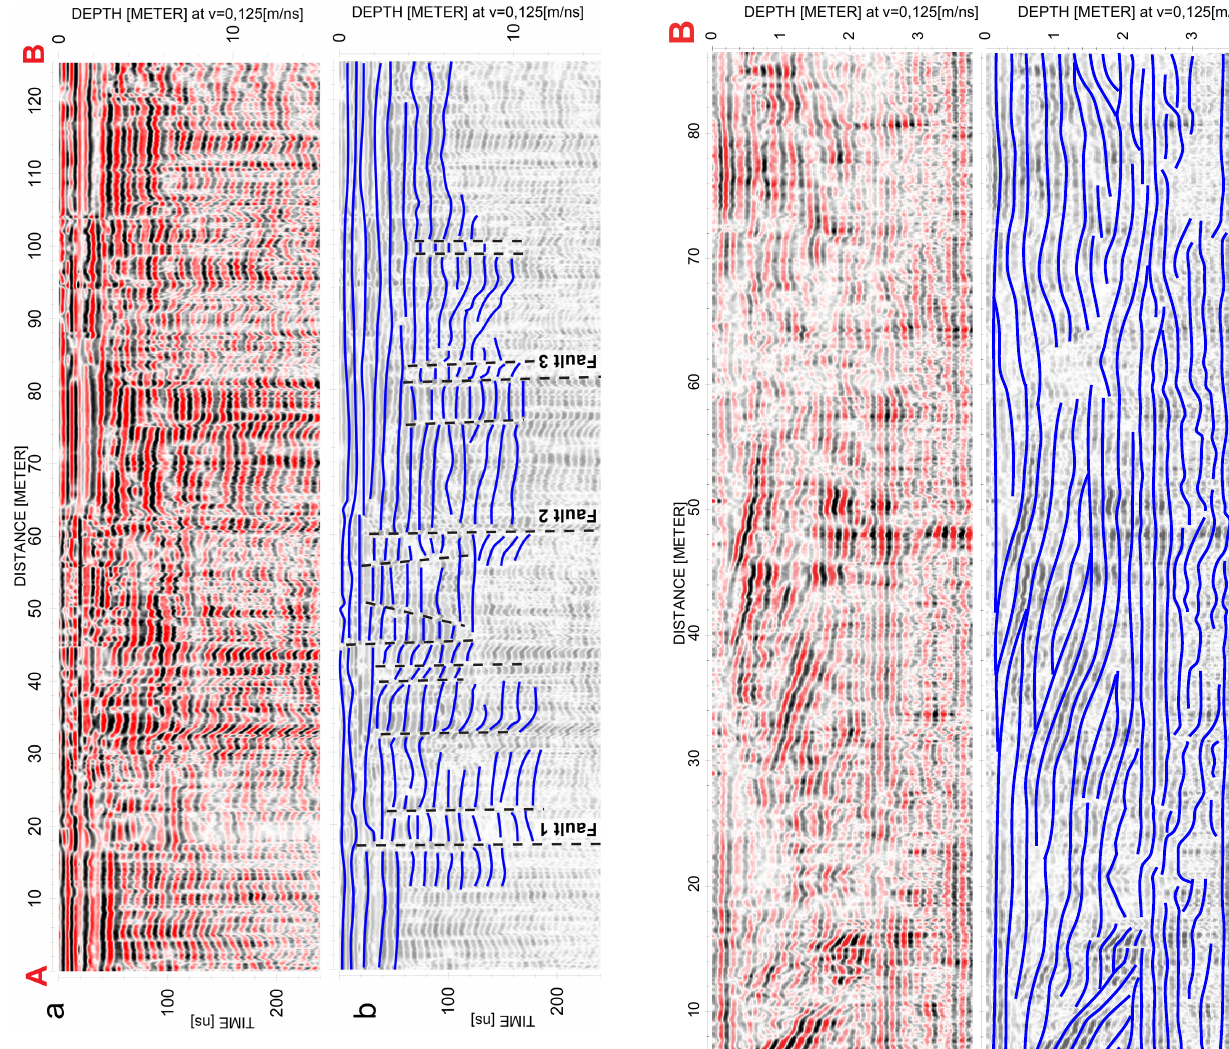
Figure 12. NW–SE profile in northern Cyclone Canyon. (a) 100MHz profile without interpretation. (b) Profile with inter- pretation (blue lines: interpreted layers; dashed lines: interpreted faults). Faults 1–3 are also shown in Fig. 11a.